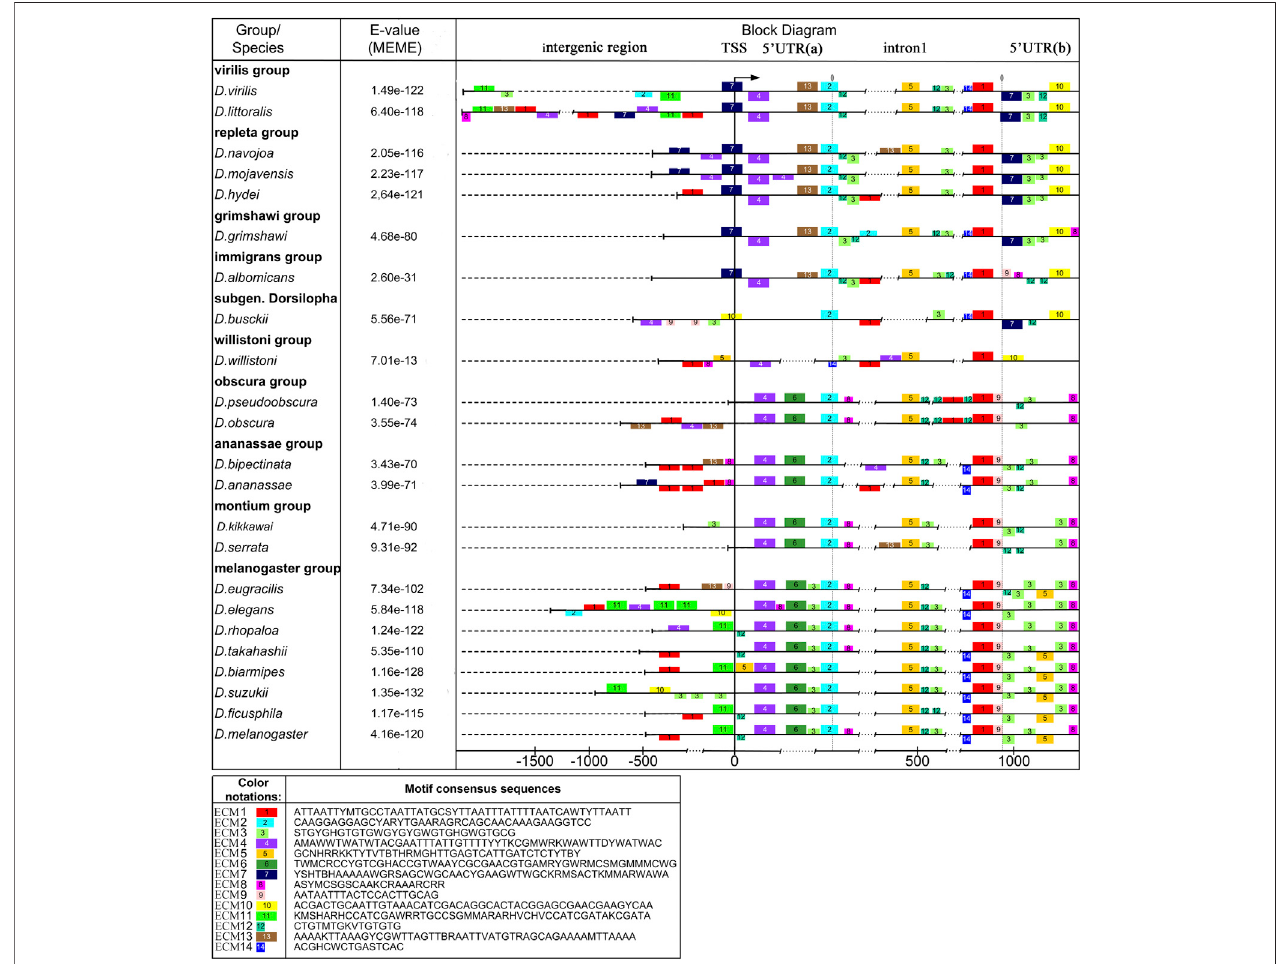
FIGURE 1 | Polymorphism of the intergenic region, promoter, 5 ′ UTR, and intron 1 in Drosophila species with different degrees of relationship. Scheme of the distribution of evolutionarily conserved sequences and insertion-deletion polymorphism in the analyzed region of the ras85D gene. The structure of evolutionarily conserved sequences which were obtained using theMEMEalgorithm. In thescheme, theboxes above theline show thelocation ofECMs on the plus strand,whilethe boxes below the line show ECM location on the minus-strand. The reduced box height marks degenerate ECMs. The upper part shows species of the subgenus Drosophila (D. virilis — D. albomicans), and in the lower part, there are species of the subgenus Sophophora (D. willistoni — D. melanogaster). D. busckii ( subgenus Dorsilopha) is located between the subgenera Drosophila and Sophophora .